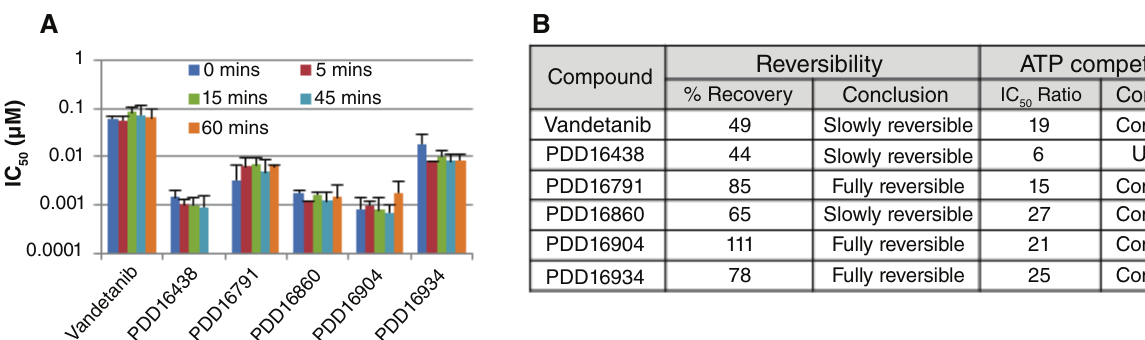
Figure 1. Mechanism of inhibition data. ( A ) Effect of increasing pre-incubation time (5–60 mins) on compound IC results of reversibility and ATP competition